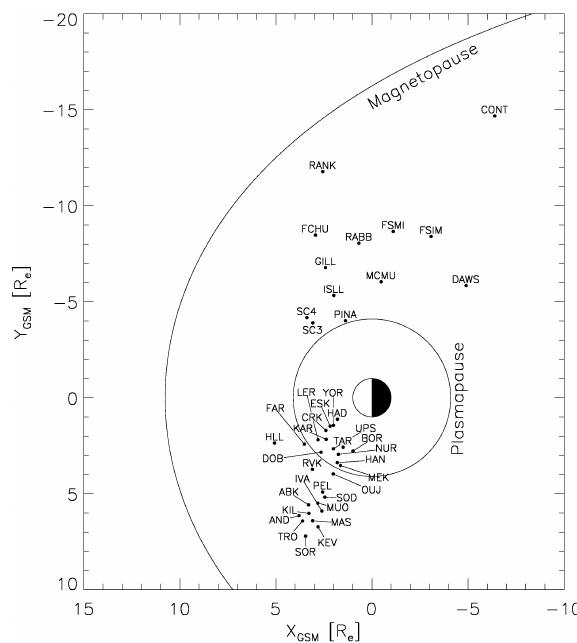
Fig. 5. Equatorial crossing points of field lines adjacent to ground magnetometer stations in GSM coordinates. The magnetopause po- sition was calculated according to Shue et al. (1997). The plasma- pause is shown following Larsen et al. (2007).